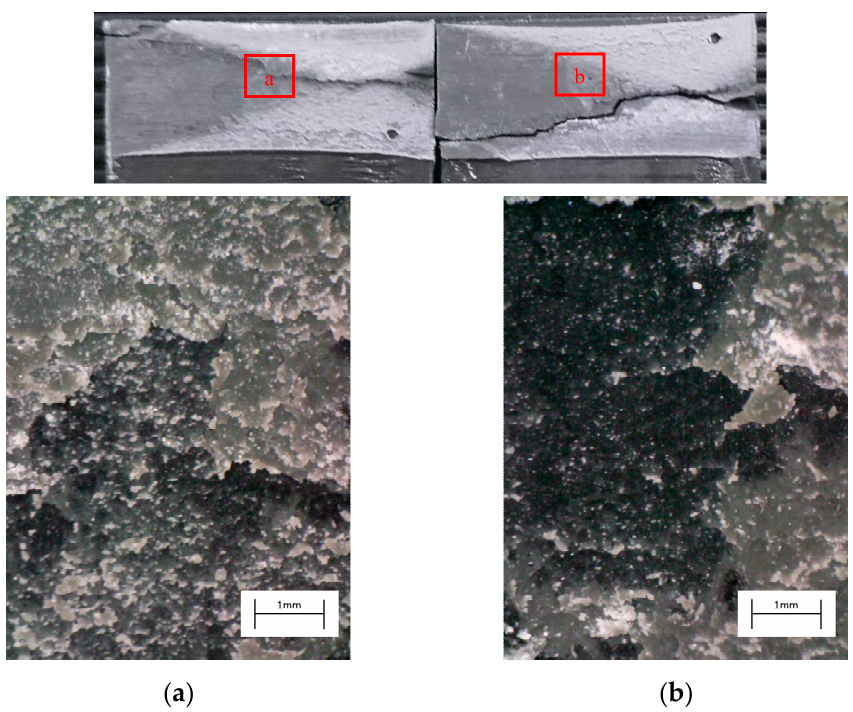
Figure 11. Fracture surface of a specimen pretreated with abrasion + APPT with D = 5 mm and v = 100 mm/s and subjected to quasi-static tensile test, with magnified details ( a ) and ( b ) acquired by microscope.